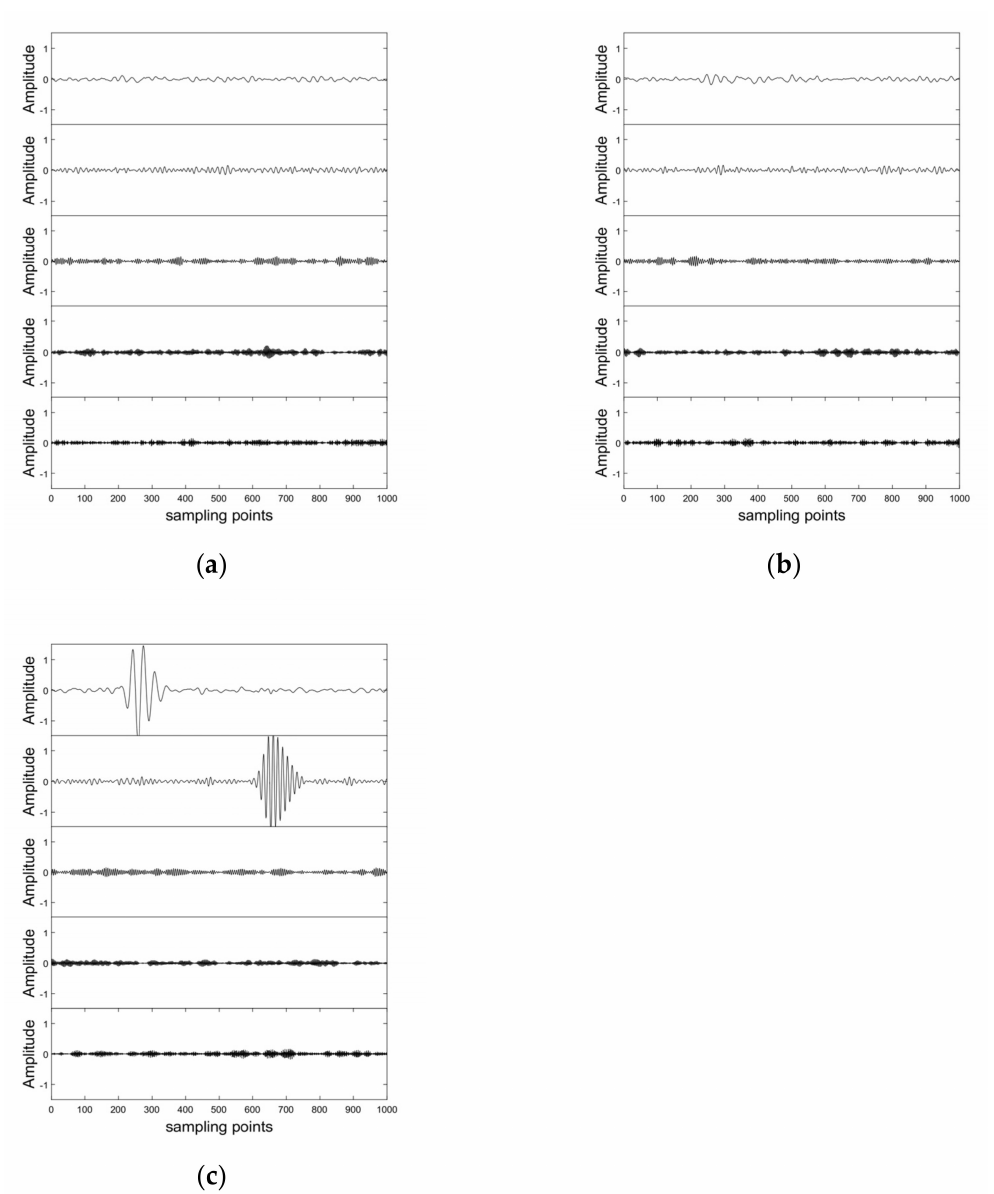
Figure 6. The IMFs of re-constrain VMD for the three-component data and the horizontal components without pure synthetic data. ( a ) The re-constrain VMD result of the H1 component without valid data. ( b ) The re-constrain VMD result of the H2 component without valid data. ( c ) The re-constrain VMD result of the vertical component with valid data.